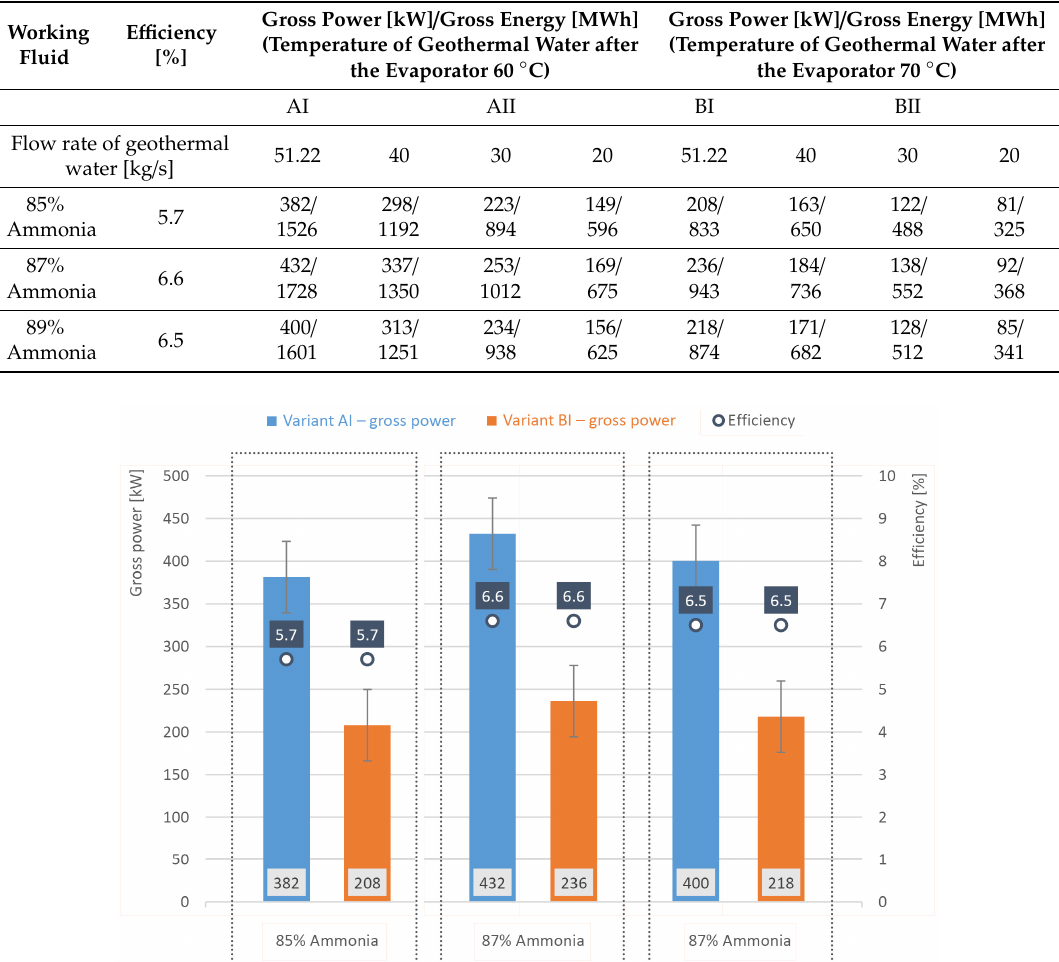
Figure 8. Comparison of the amount of electricity it is possible to generate in the AI and BI variants using the Kalina Cycle.